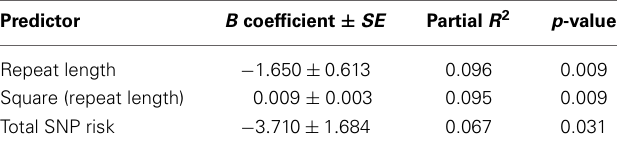
Table 5 | Linear regression model showing the significant association of “Total SNP Risk” variable that sums the weighted genotypes over five SNPs known to influence age at menopause (see text), adjusting for variables of PM repeat length.